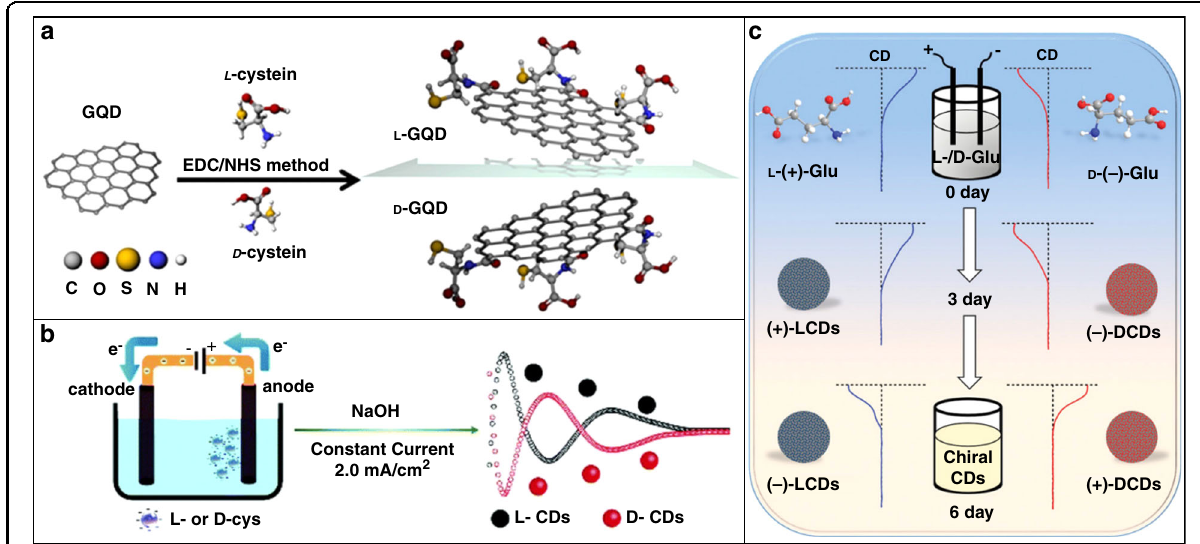
Fig. 2 Examples of top-down synthesis of chiral carbon dots. a Surface treatment of graphene quantum dots with cysteine; b electrochemical exfoliation of graphite anode in the presence of L/D-cysteine; c electrochemical exfoliation of a graphite anode in the presence of L/D-glutamic acid. a Adapted with permission from 53 Copyright 2016 American Chemical Society. b Adapted with permission from 135 Copyright 2018 Royal Society